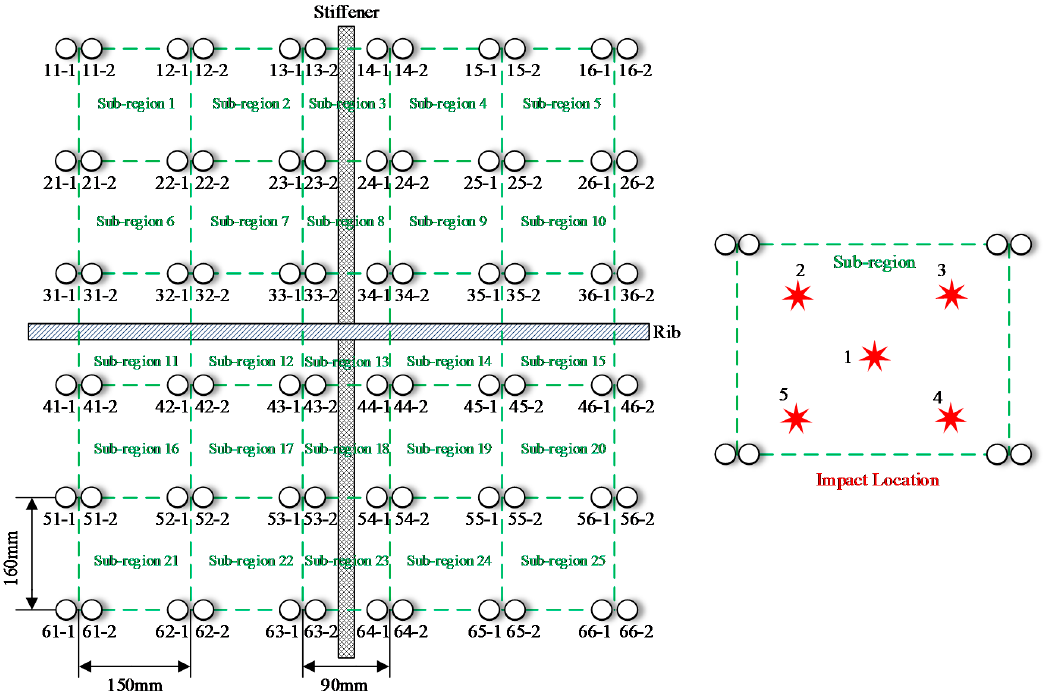
Figure 23. Illustration of PZT sensor placement on the UAV composite skin.